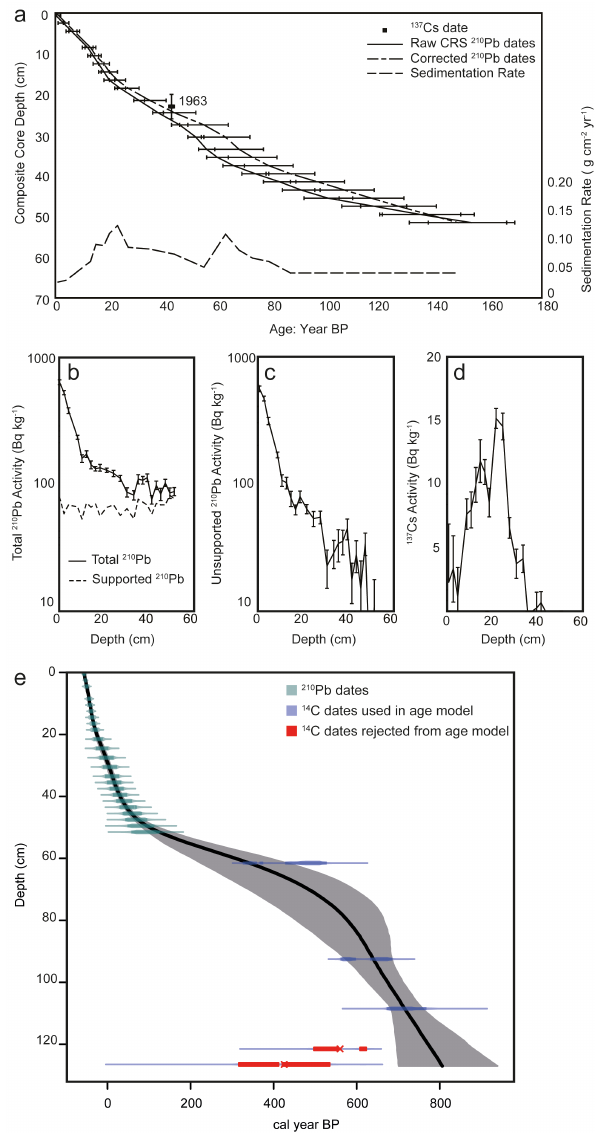
Figure 3. Radiometric dating of the Lake Kyasanduka sediment core (a) 210 Pb and 137 Cs chronology and sedimentation rate. Fall- out radionuclides (versus depth) of (b) supported and unsupported 210 Pb, (c) unsupported 210 Pb, (d) 137 Cs concentrations, and (e) fi- nal age model; the grey envelope highlights the chronological un- certainty in the record. The grey band at ca. 125cm is likely coinci- dent with a period of inferred catchment in wash (simultaneous de- position event), as evidenced by high magnetic susceptibility, low organic content (Figs. S2 and S3, Supplement) and an increase in the number of aerophilous taxa in the